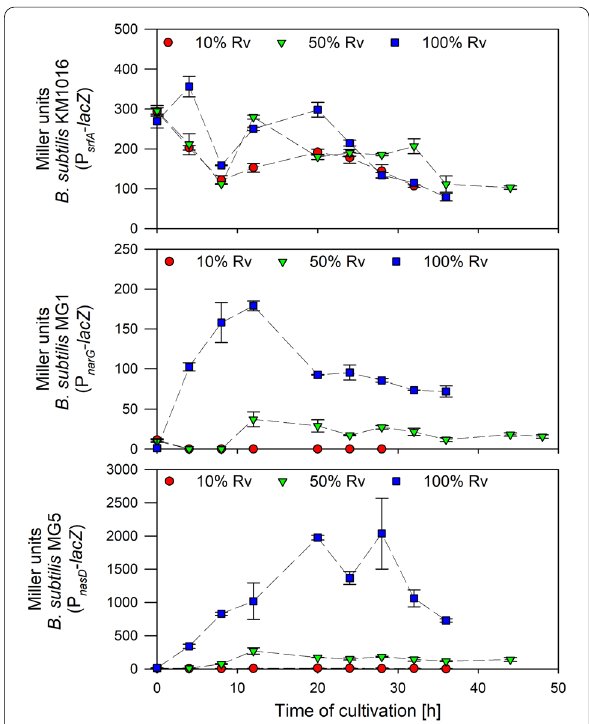
Fig. 2 Time course of Miller units determined by the Miller Assay representing expression of promoters P srfA , P narG and P nasD . Data recorded until CDW max of cultivation of strains B. subtilis KM1016 (P srfA - lacZ ), MG1 (P narG - lacZ ) and MG5 (P nasD - lacZ ) in a mineral salt medium employing 40 g/L glucose, 0.1 mol/L NH 4 + and 0.1 mol/L NO 3 − in baffled shake flasks with three different relative filling volumes (Rv) of 10%, 50% and 100% representing different oxygen